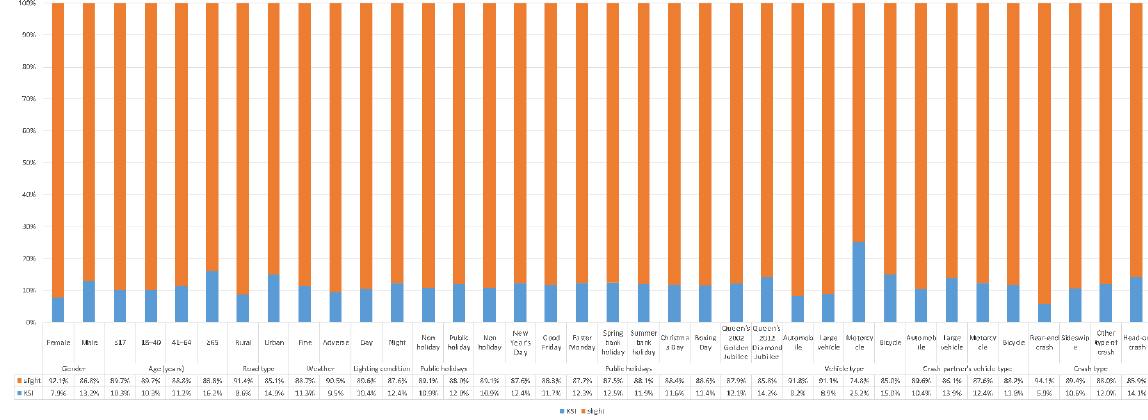
Figure A2. Distribution of injury severity for each independent variables in the UK STATS19 data [24].